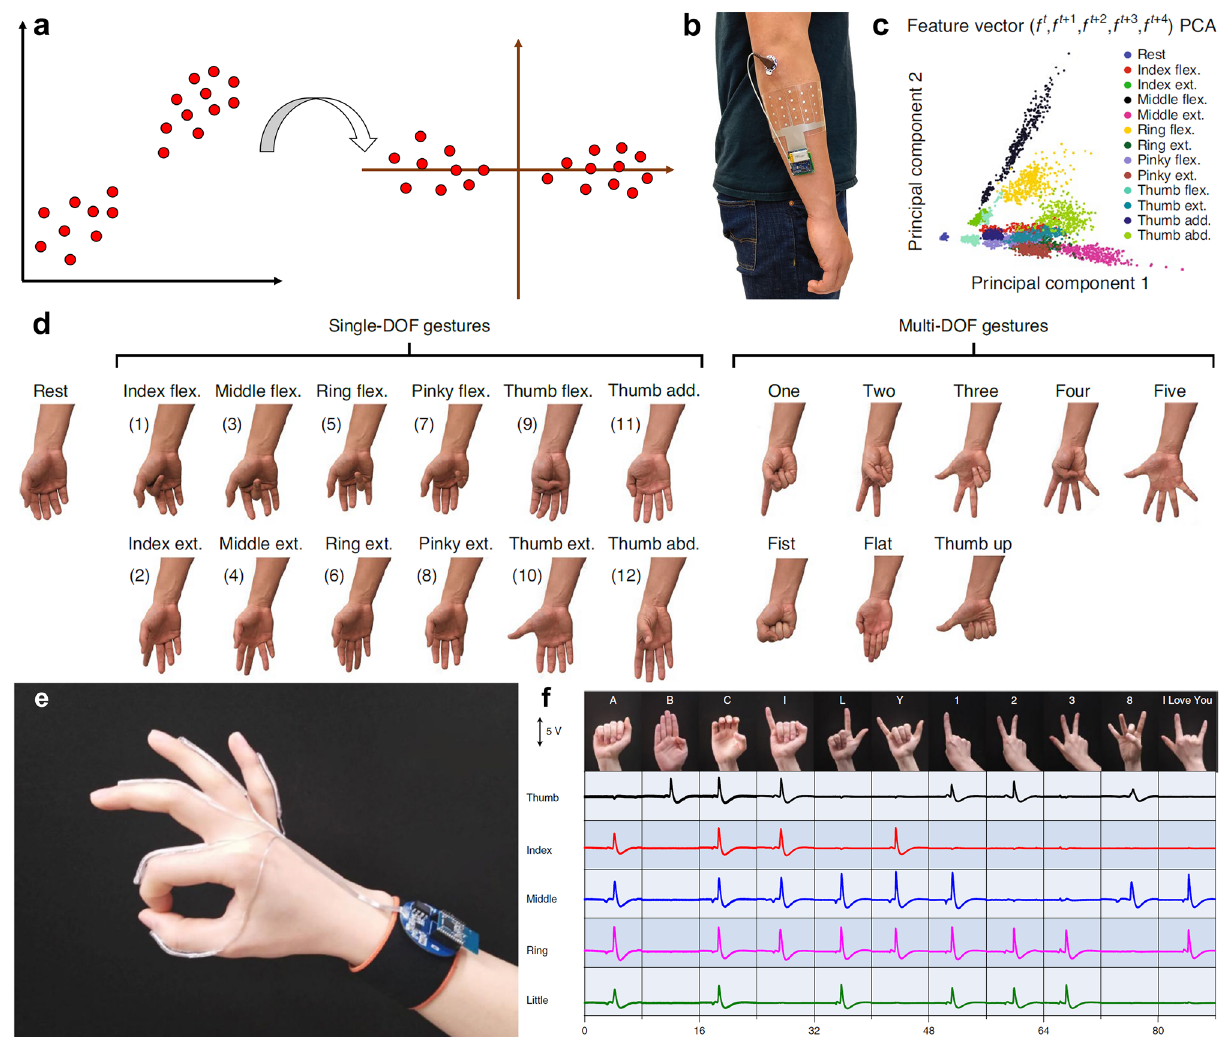
Fig. 15 Signals detected by the soft system and processed by PCA. a Schematic diagram of PCA. b 64 channels sEMG detected system on the forearm of a participant. c Single-DOF gesture subset. The multi-DOF gesture subset. d PCA for all classification windows from five trials of 13 single-degrees of freedom gestures. The top two principal components are plotted for features. Reproduced with permission [312]. Copyright (2021), Springer Nature. e Photograph of YSSA and the wireless PCB attached on a subject’s hand. f Photographs of the sign language hand gestures according to ASL and the corresponding voltage profiles generated by YSSA as recognition pattern. Reproduced with permission [31]. Copyright (2020), Springer